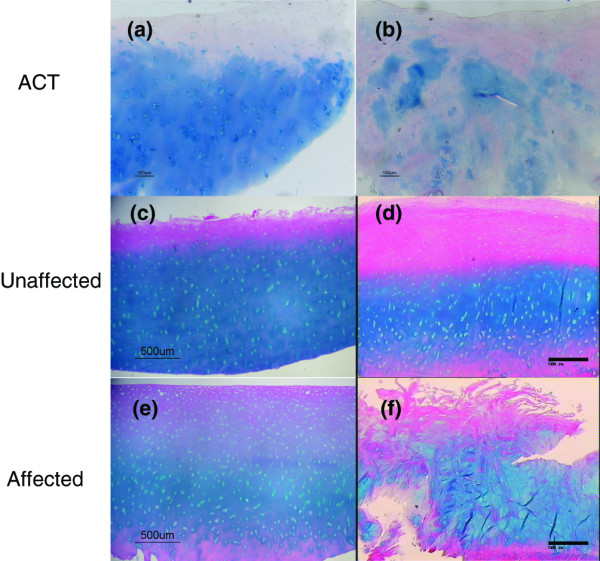
Histology of biopsies. The figure shows sections stained with Alcian blue/van Gieson. The biopsies originate from two representative autologous chondrocyte transplantation patients (ACT) (a, b) and from the unaffected and affected side from two patients with osteoarthritis (OA) undergoing total knee replacement (c–f). (c, e) Biopsy from one OA donor (female, aged 81 years) with a Mankin score of 1.5 on both sides. (d, f) Biopsy from another OA donor (male, aged 74 years) with Mankin scores of 5 (d) and 11 (f).